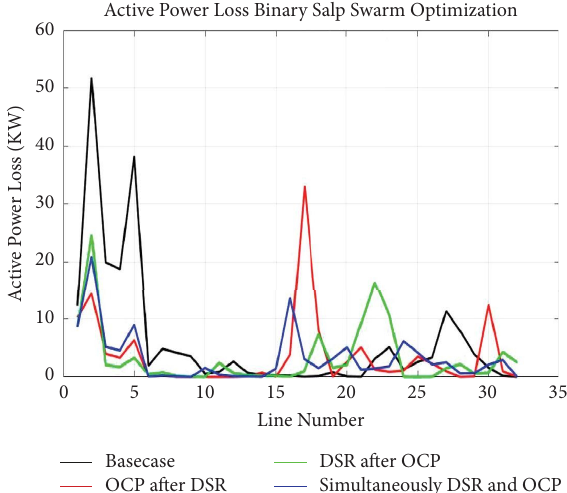
Figure 10: Active losses curve for 33-bus with using the BSSA algorithm for three scenarios with the base case.